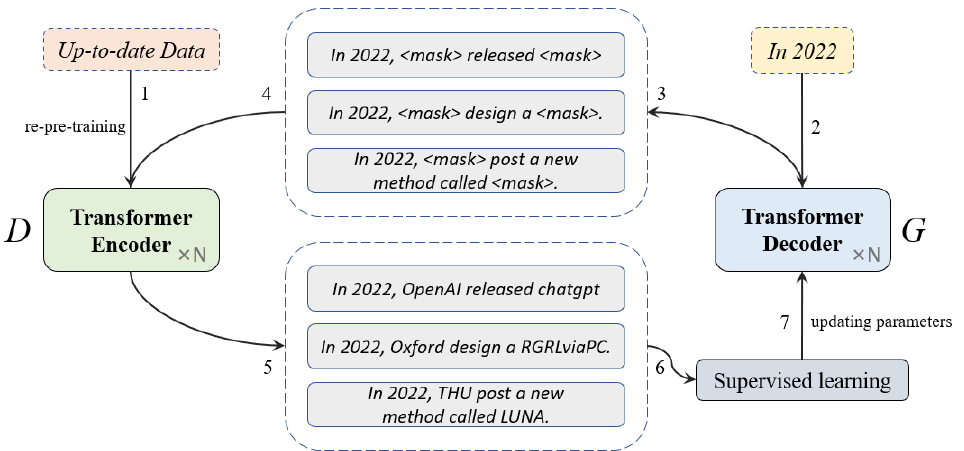
Figure 2. The process of learning up-to-date knowledge. The probability of being masked in this case is 15%, which is the same proportion as in the pretraining of